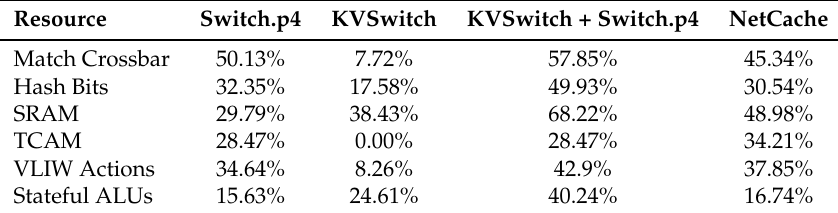
Table 1. Hardware resource cost in ASIC